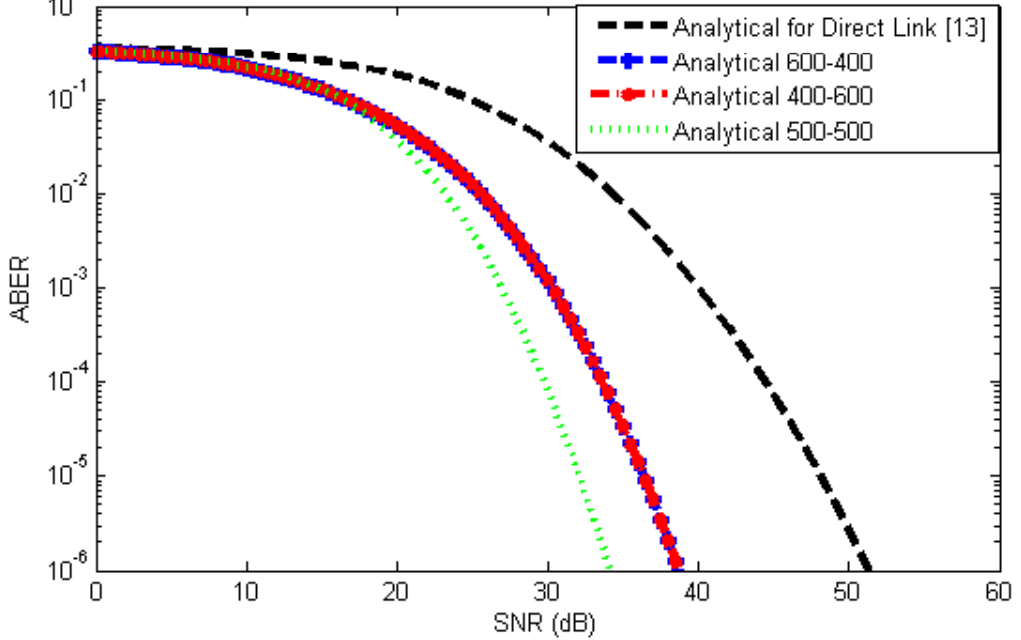
Figure 5. ABER performance for the direct link and a single relay with different locations, over moderate turbulence.